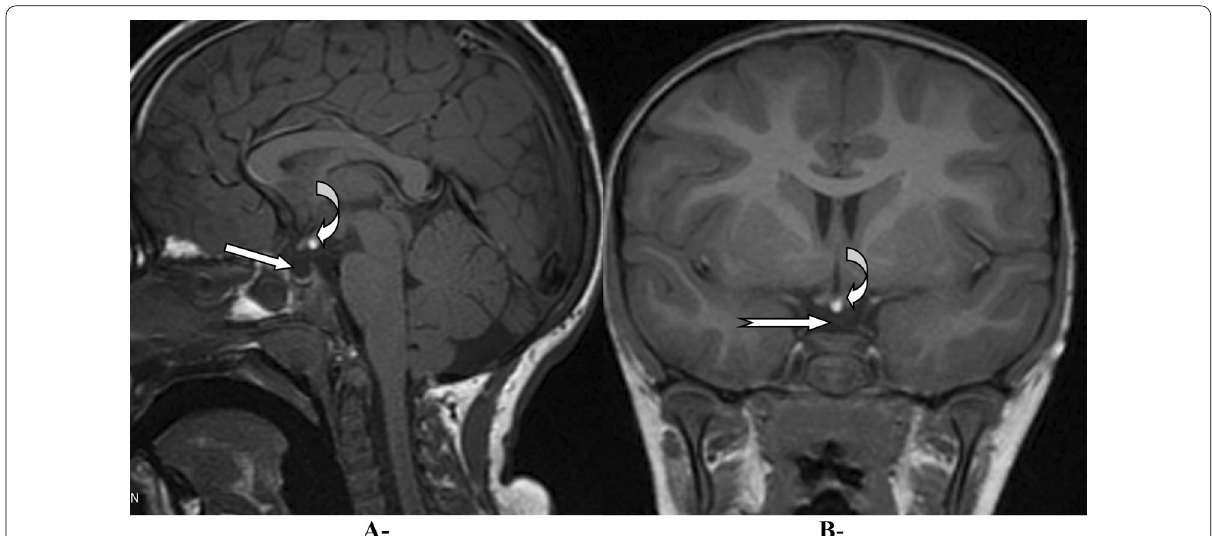
Fig. 3 A 10-year-old boy with signs of pituitary dwarfism. T1w non contrast sagittal ( A ) and coronal ( B ) MRI sequences showing hypoplastic anterior pituitary gland, hypothalamic ectopic posterior pituitary and absent